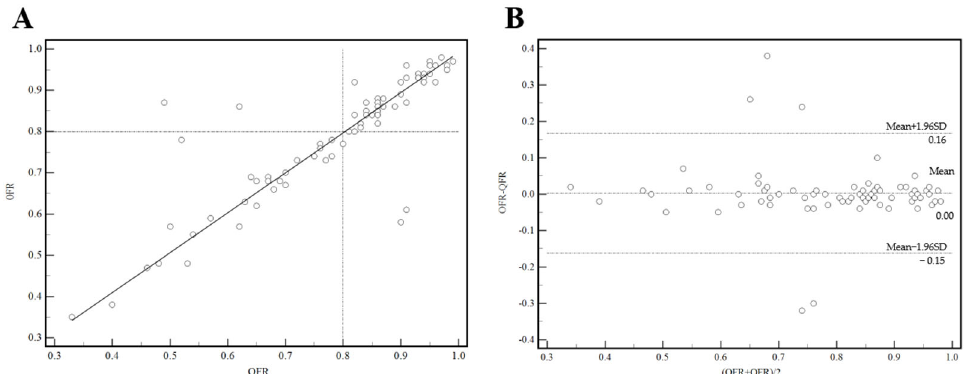
Figure 2. Association between quantitative flow ratio (OFR) and optical flow ratio (QFR). ( A ) Lineal regression between OFR and QFR, ( B ) The Bland-Altman plot presented a difference between the OFR and QFR. SD: standard deviation.